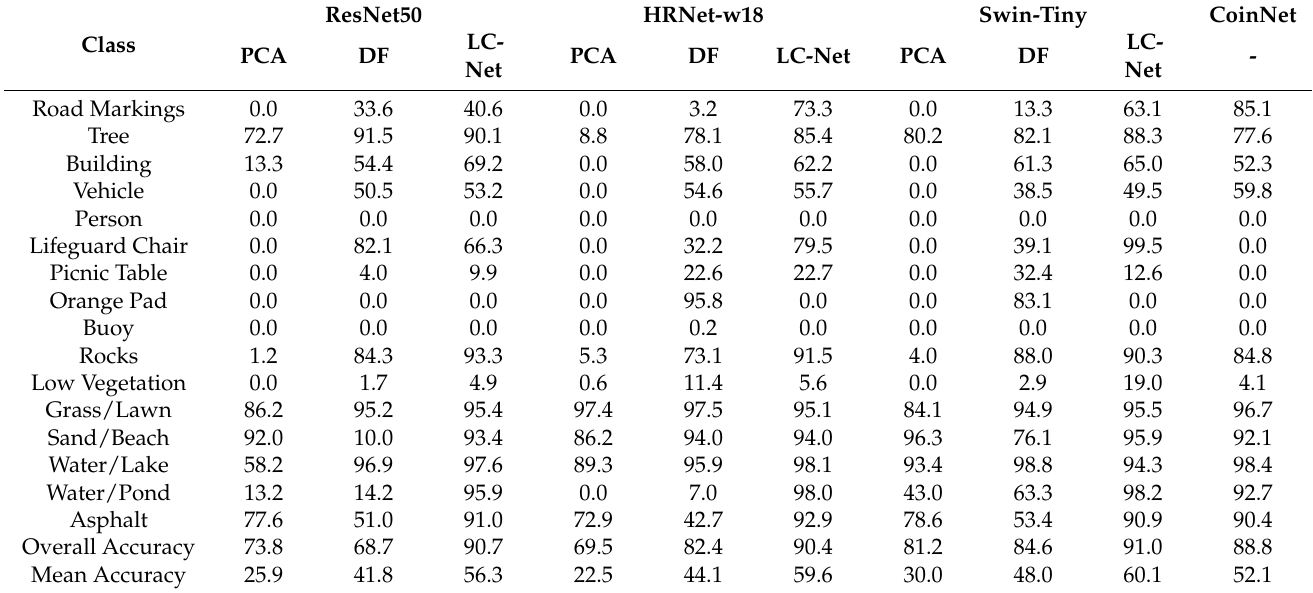
Table 4. Summary of the key performance of PCA, DF, LC-NET, and CoinNet (%).